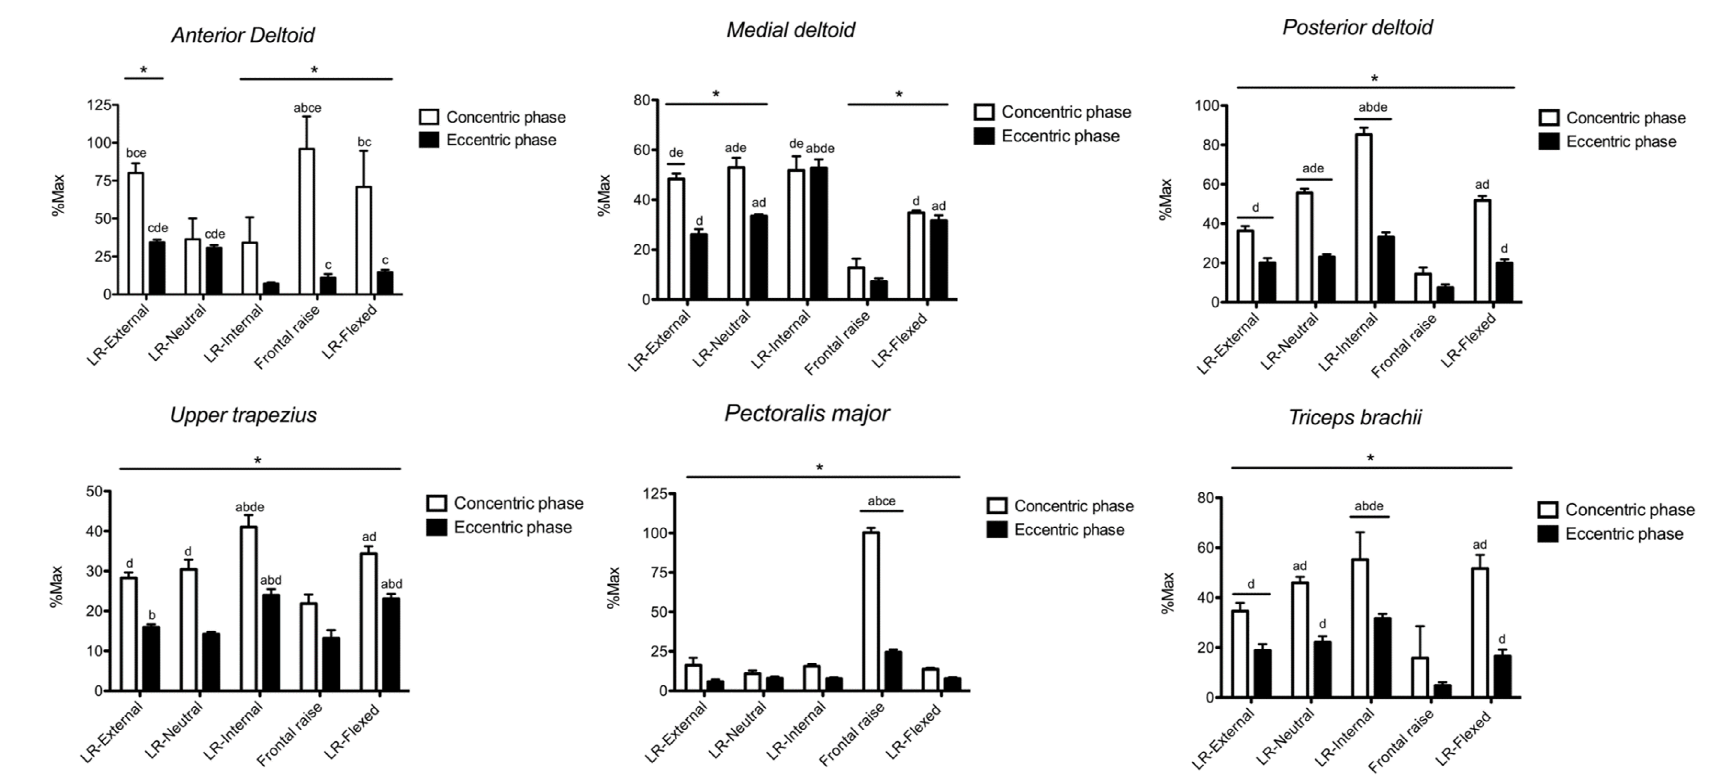
Figure 2. The normalized to maximum voluntary activation (%Max) surface electromyography root mean square is shown for each muscle during both the concentric and eccentric phase for each exercise. LR: lateral raise *: concentric > eccentric phase ( p < 0.05), a: greater than LR-external rotation ( p < 0.05), b: greater than LR-neutral rotation ( p < 0.05), c: greater than LR-internal rotation ( p < 0.05), d: greater than frontal raise ( p < 0.05), e: greater than LR-flexed elbow ( p < 0.05)